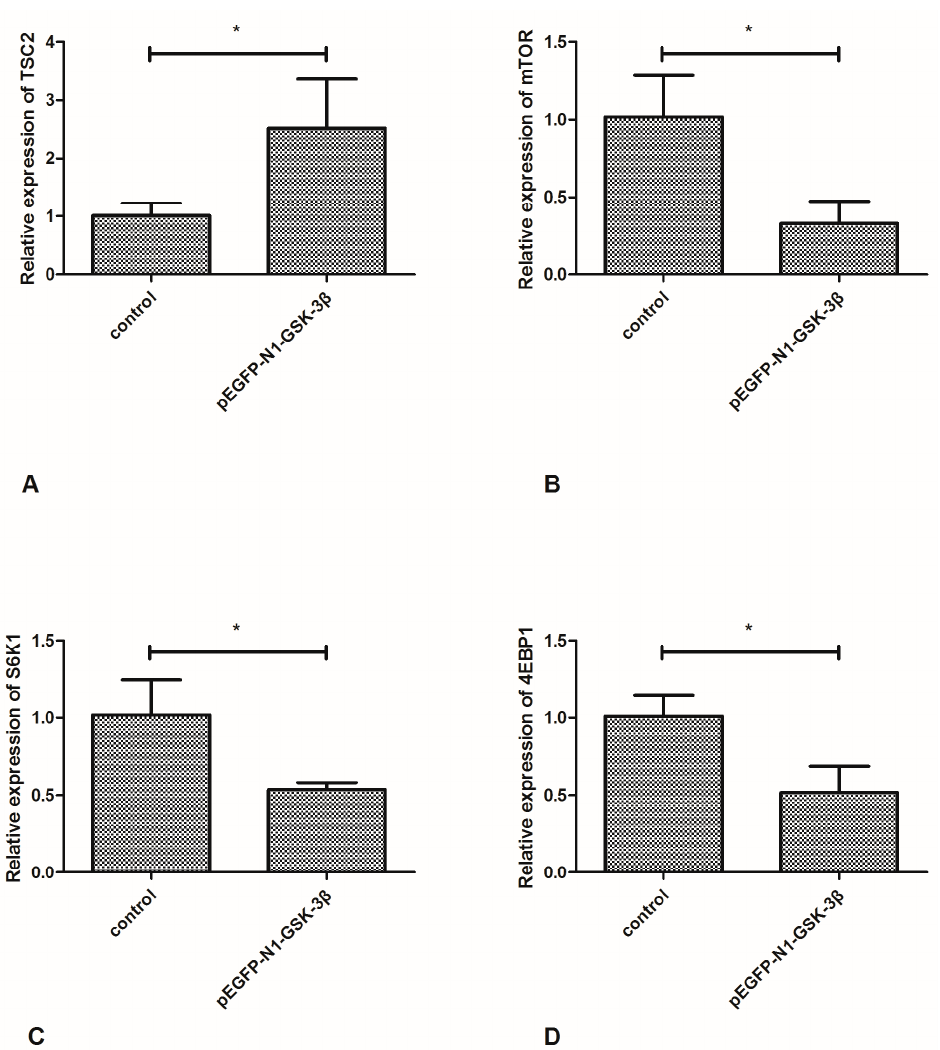
Figure 6. Effect of the pEGFP-N1-GSK-3 β vector on the mRNA expression of TSC2, mTOR, S6K1, and 4EBP1 in the muscle of zebrafish. ( A ) TSC2; ( B ) mTOR; ( C ) S6K1; ( D ) 4EBP1. Values are expressed as means ± s.e.m. ( n = 6). Statistically significant differences are denoted by asterisk ( p < 0.05).